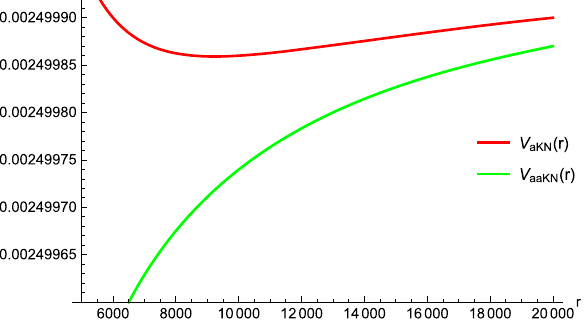
Fig. 3 Asymptotic forms of V aKN ( r ) and V aaKN ( r ) . V aKN ( r ) shows a tiny well located at r = 9228 . 69 and it approaches V aaKN ( r ) for r > 9228 . 69. All coefficients go together with this figure